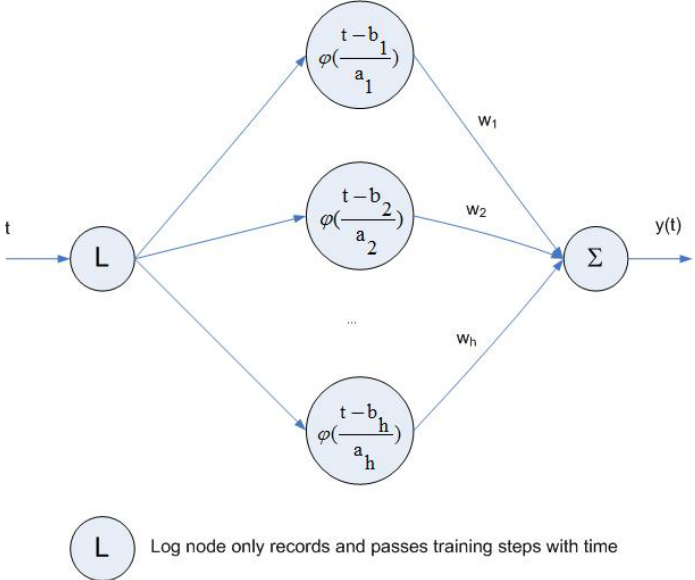
Figure 8. Structure of